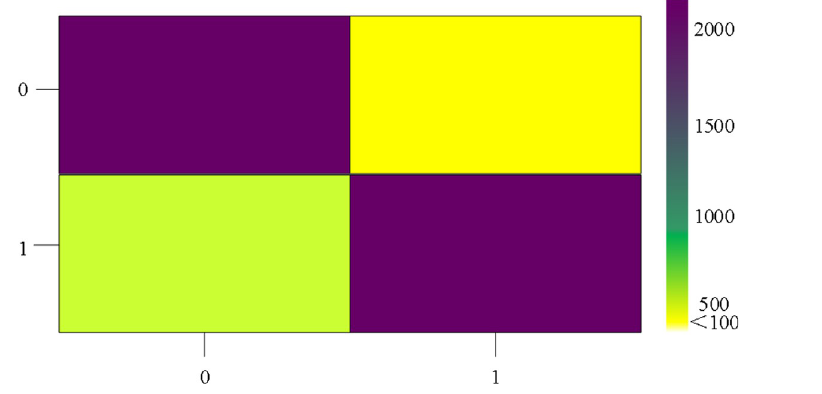
Fig 12. Confusion matrix of the